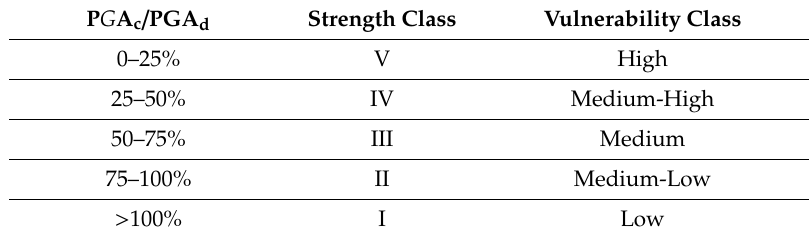
Table 10. Vulnerability classification according to the RE.SIS.TO ® method